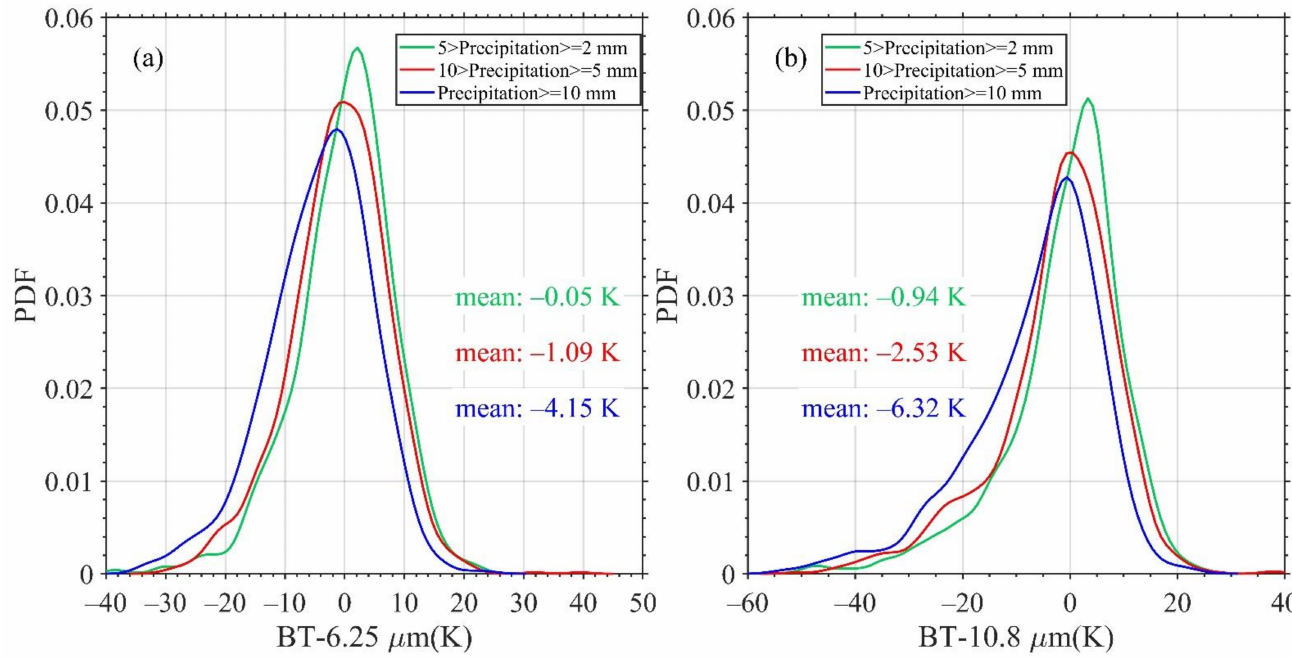
Figure 5. The relationship between the hourly precipitation and the hourly variation rate of TB for ( a ) WV channel 9 and ( b ) LWIR channel 12 from June to August of